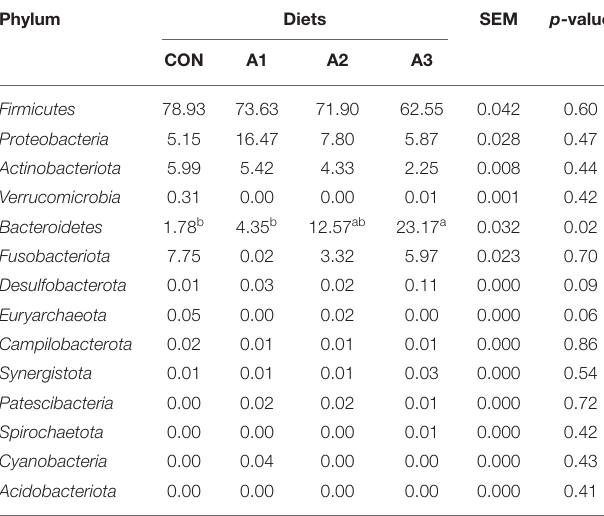
TABLE 5 | Effects of Anemoside B4 on the comparison of dominant phylum of suckling calves at 56 days of age (%). Phylum Diets SEM p